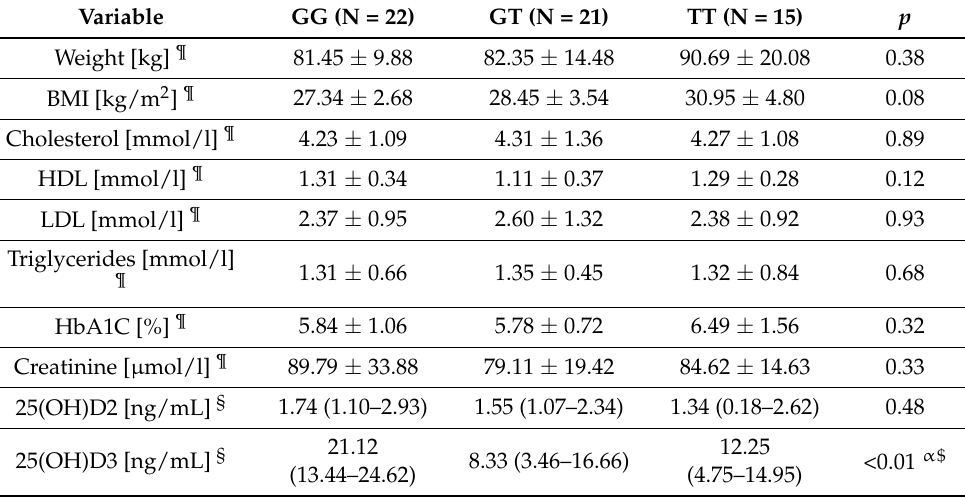
Table 3. Patient characteristics according to the ApaI